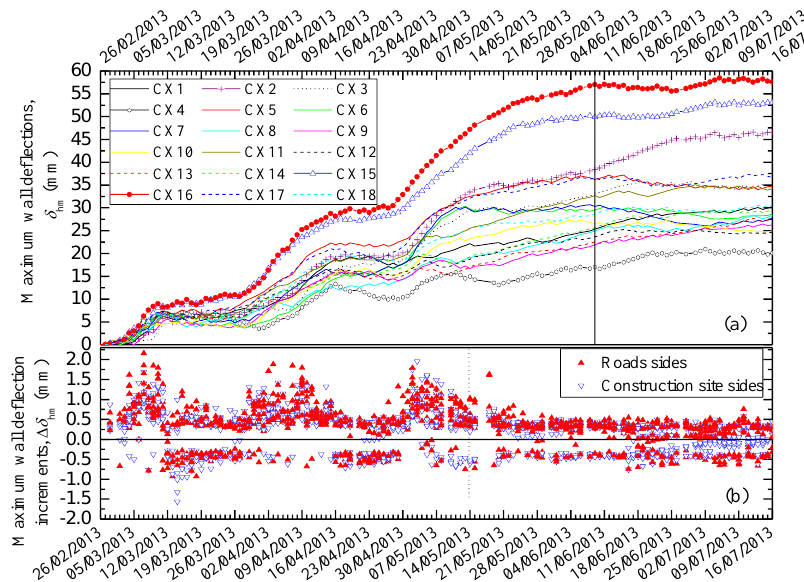
Figure 6. Wall performance over time: ( a ) maximum wall deflections; ( b ) maximum wall deflection increments.